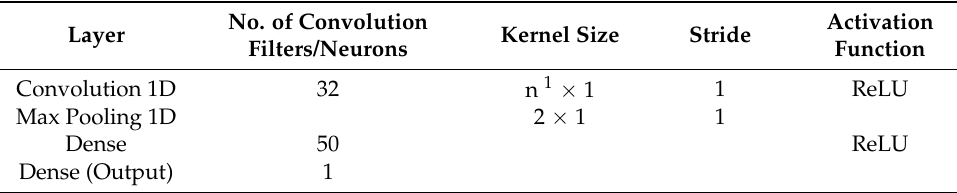
Table 4. Layer configuration of the multivariate CNN model.